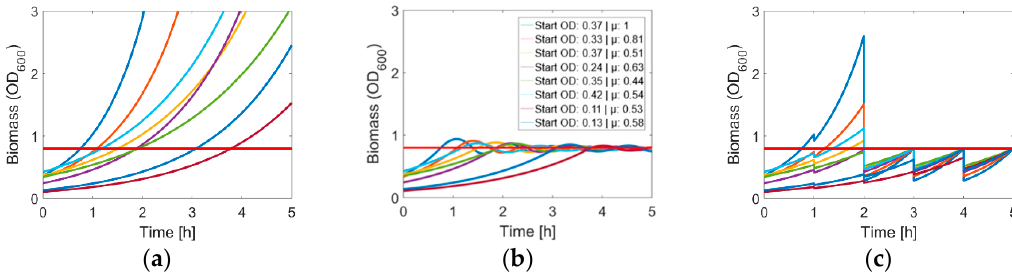
Figure 1. Illustrated overview of possible cultivation modes for the preparation of competent cells. Values for initial biomass and µ were chosen randomly; red line: threshold for harvesting (Optical Density (OD) = 0.8). The used models could be seen in the appendix. ( a ) Batch cultivation; ( b ) chemostat cultivation; ( c ) quasi-turbidostat cultivation.